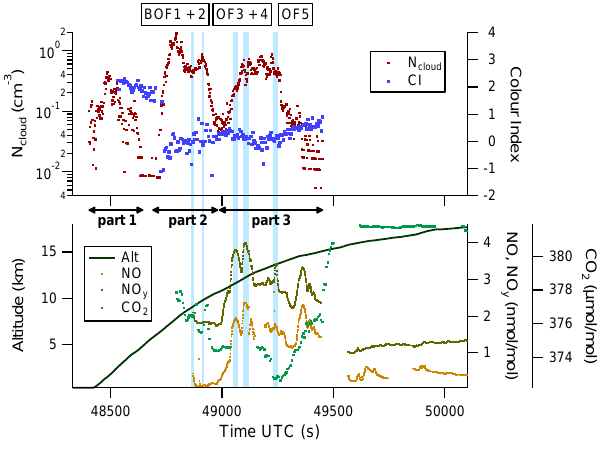
Fig. 13. Time series showing the ascent through the MCS anvil on 16 August 2006. The shading indicates time periods which were selected for deriving the ice particle size distributions from Fig. 14. (See text for details.) Fig. 14. Selected size distributions from the ascent on 16 August